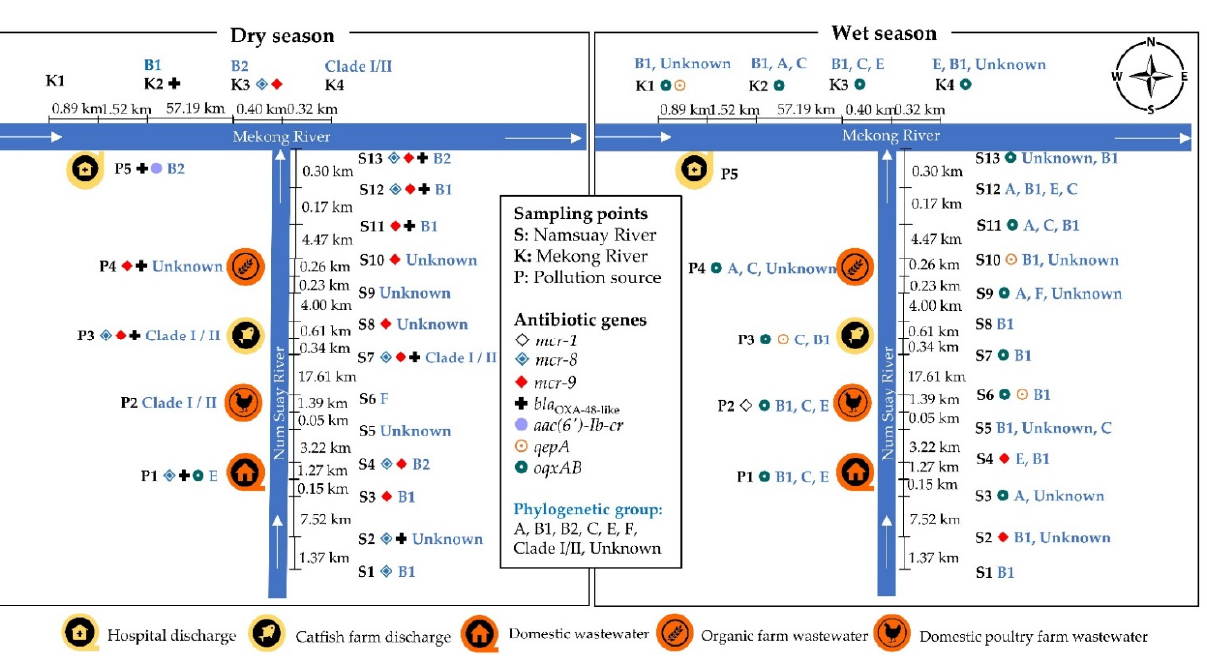
31 Table 6. Association between antibiotic susceptibility and antibiotic resistance genes of E. coli and season (dry and wet). Phenotypic and Genotypic Antibiotic Resistance in E. coli